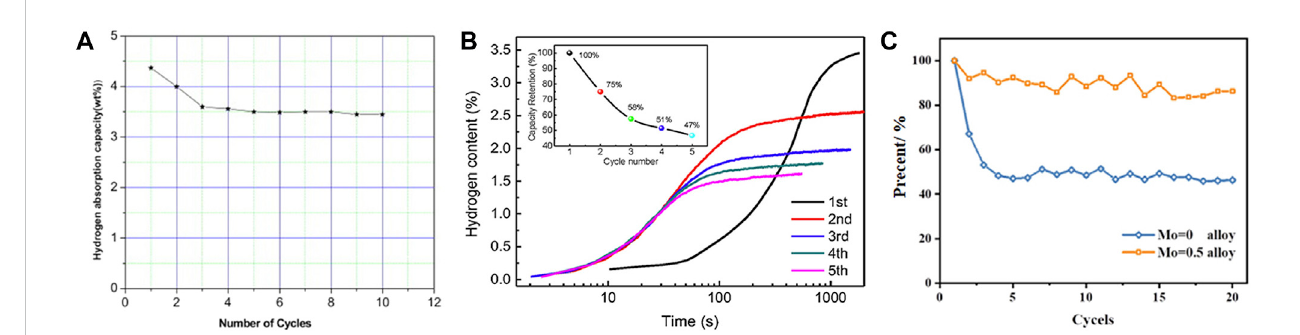
FIGURE 6 Hydrogen capacity of Ti 2 VCr alloy for 10 cycles at room temperature (the alloy is heated at 673 K under diffusion vacuum before each cycle) (A) (Kumar et al., 2011); hydrogen absorption curve of V 0.3 Ti 0.3 Cr 0.25 Mn 0.1 Nb 0.05 alloy within 5 cycles (B) (Liu et al., 2022b); comparison of cycling performance of Ti2VCr alloy before and after chemical modi fi cation (Mo instead of Ti) (C) (Hu et al.,